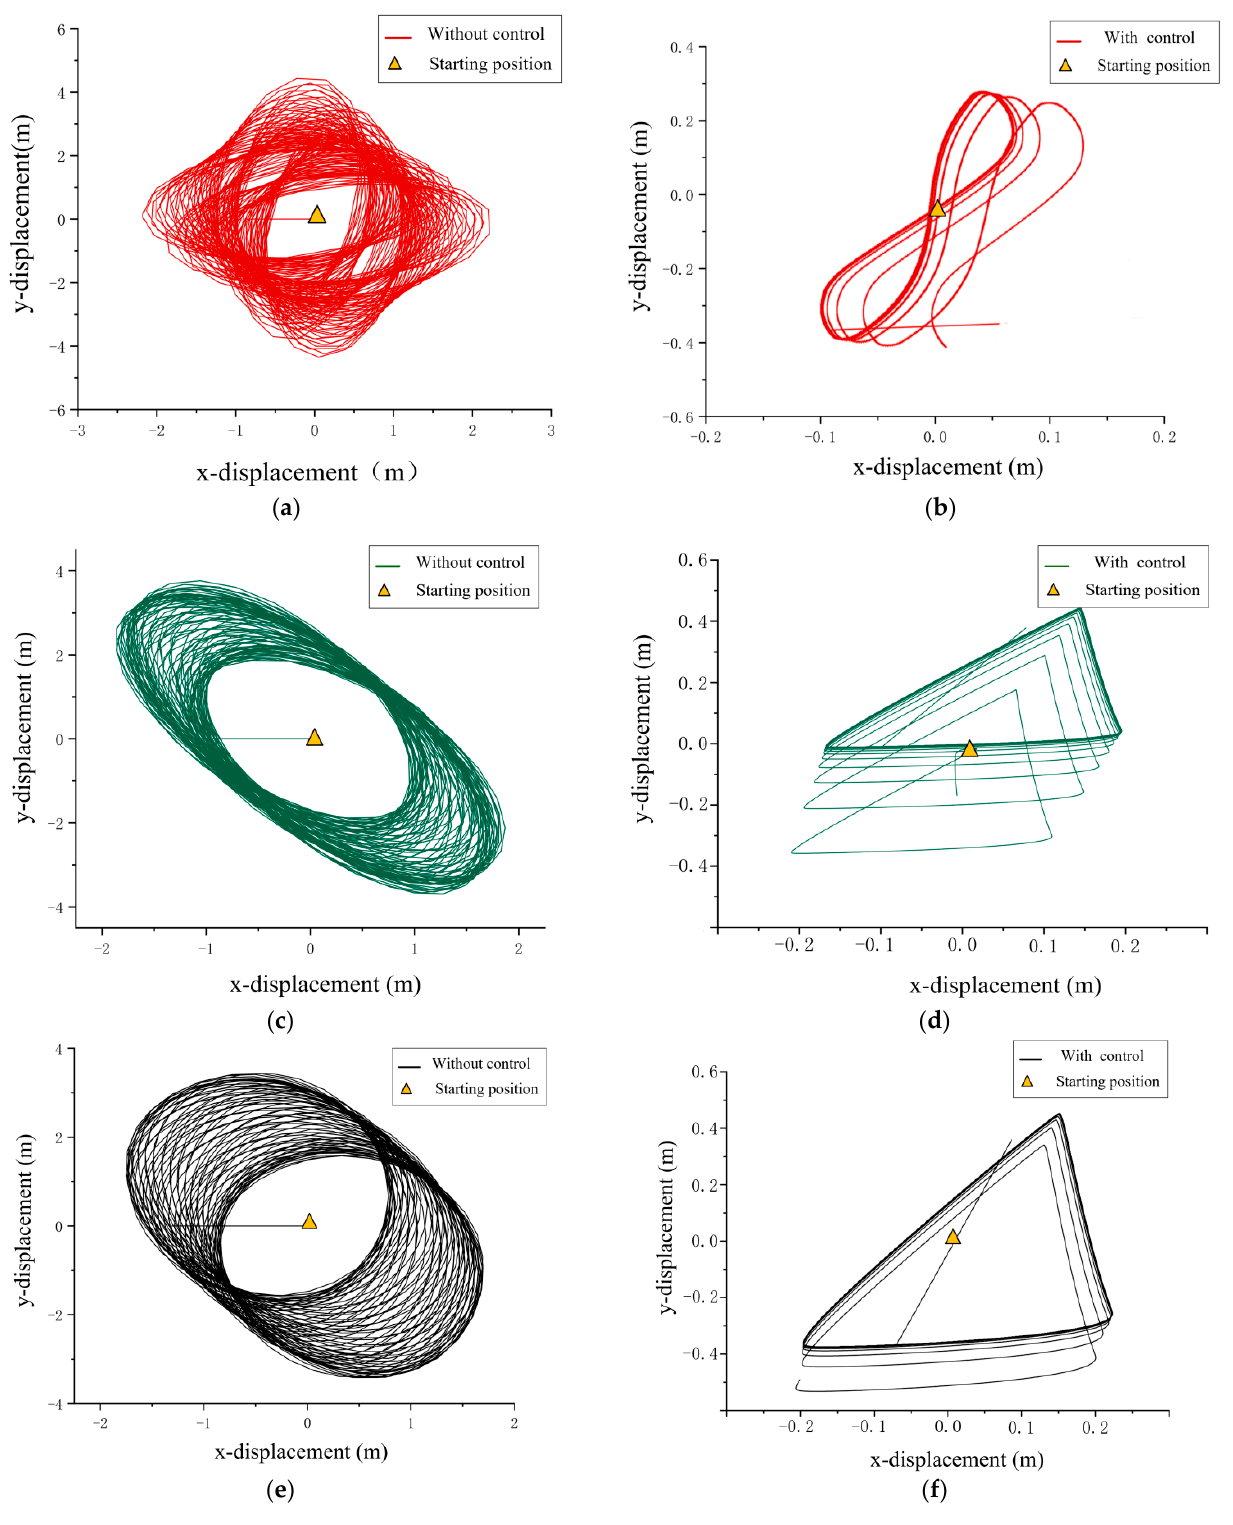
Figure 12. The dynamic response of TTAS under Condition 2. ( a ) the x, y displacement without control of the payload when the hoist cable is 0.6 m; ( b ) the x, y displacement with control of the payload when the hoist cable is 0.6 m; ( c ) the x, y displacement without control of the payload when the hoist cable is 1.2 m; ( d ) the x, y displacement with control of the payload when the hoist cable is 1.2 m; ( e ) the x, y displacement without control of the payload when the hoist cable is 1.8 m; ( f ) the x, y displacement with control of the payload when the hoist cable is 1.8 m.